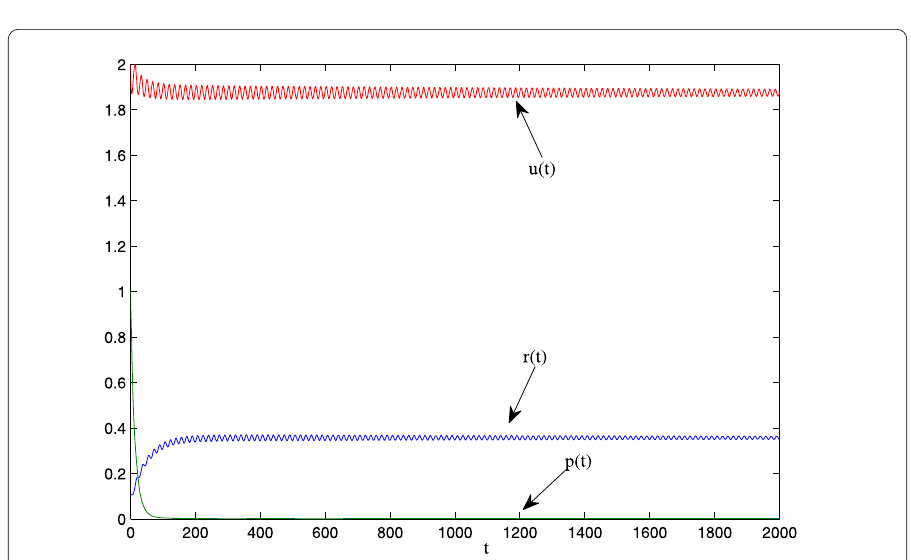
Figure 3 A periodic oscillation with delay τ = 13.59. The parameters of system (5) are c 1 = 0.8, c 2 = 0.1, c 3 = 0.9, c 4 = 0.6, s 1 = 0.6, s 2 = 0.1, b = 0.3, d 1 = 0.9, d 2 = 0.1, d 3 = 0.1, and α = 0.98; the initial values are r ( t ) = 0.1, p ( t ) = 1, u ( t ) = 2 ( t ∈ [– τ ,0]). The Hopf bifurcation critical value τ a ≈ 13.5888. It depicts a periodic oscillation bifurcating from the equilibrium ( r ∗ 2 , p ∗ 2 , u ∗ 2 ) ≈ (0.3571,0,1.875) with time delay τ = 13.59 > τ